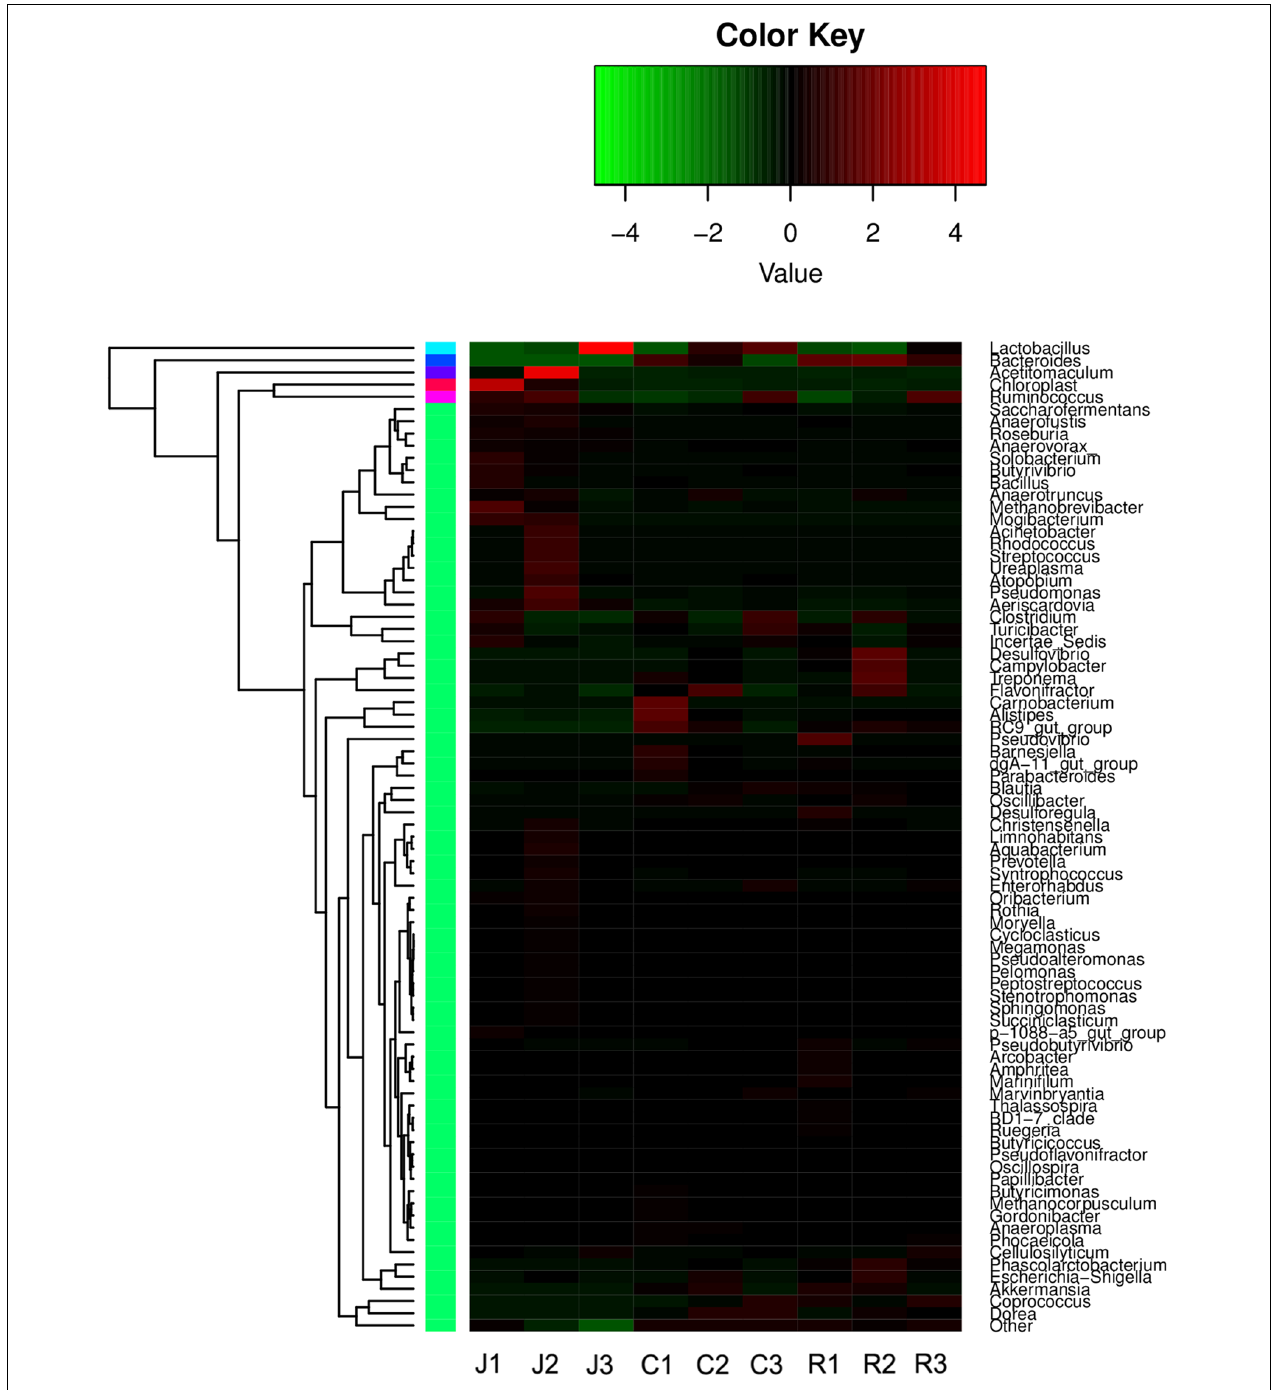
FIGURE 3 | Heatmap of hierarchy cluster results for the abundance of genus in different intestine segments.